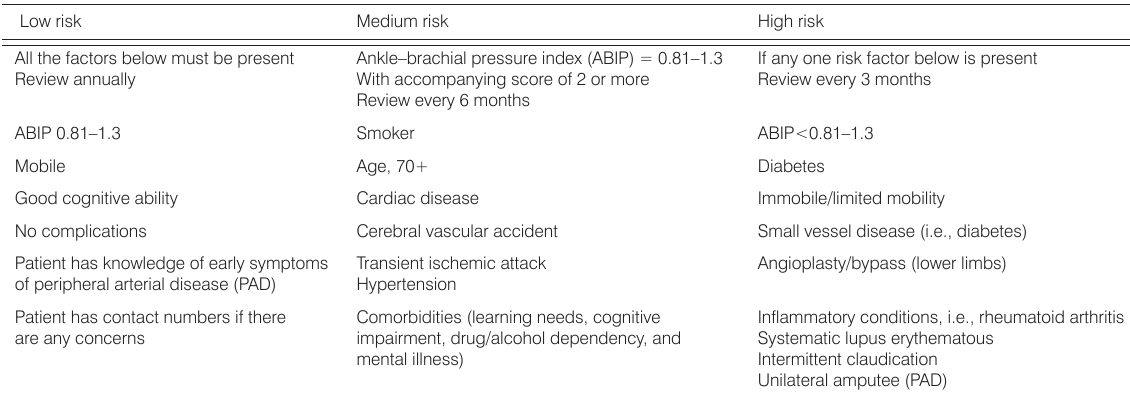
Table 3. Peripheral arterial risk